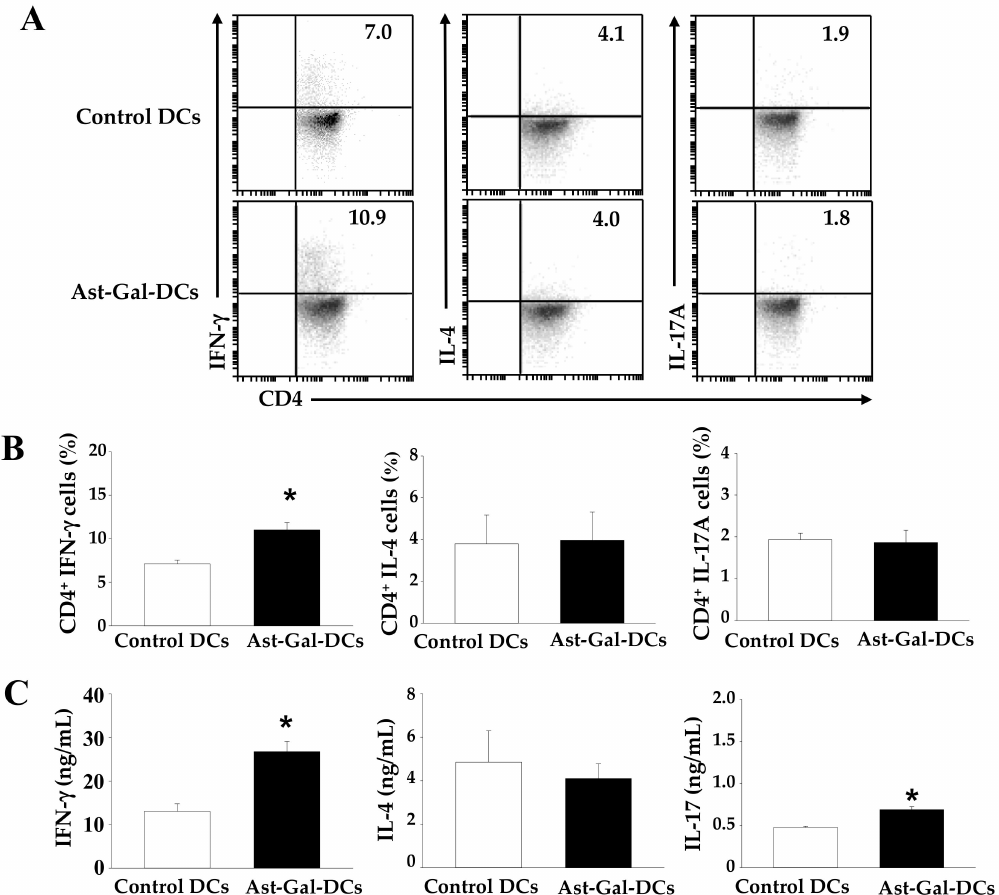
Figure 4. IL-12 secreted by the Ast-Gal-treated DCs is involved in the increased IFN- γ production in CD4 + T cells. The iDCs (5 × 10 4 cells/well) were pulsed with 10 µ g/mL OVA for 2 h, and stimulated for 6 h with Ast-Gal (200 µ M) or media alone (untreated control). Next, untreated- and treated-DCs were harvested and cocultured with OVA-specific CD4 + T cells at the ratio of 1:10 for 3 days in the presence of various concentrations of an anti-IL-12 antibody (0.1, 1, or 10 µ g/mL) or isotype control (10 µ g/mL). ( A ) The percentages of IFN- γ -expressing T-cell populations were determined by flow cytometric analysis. ( B ) The results from ( A ) are summarized as mean ± SD ( n = 3). * p < 0.05 compared with media-treated DCs. ( C ) The production levels of IFN- γ was detected by a sandwich ELISA. The data are expressed as mean ± SD from three experiments which were carried out in triplicate. * p < 0.05, ** p < 0.01 compared with media-treated